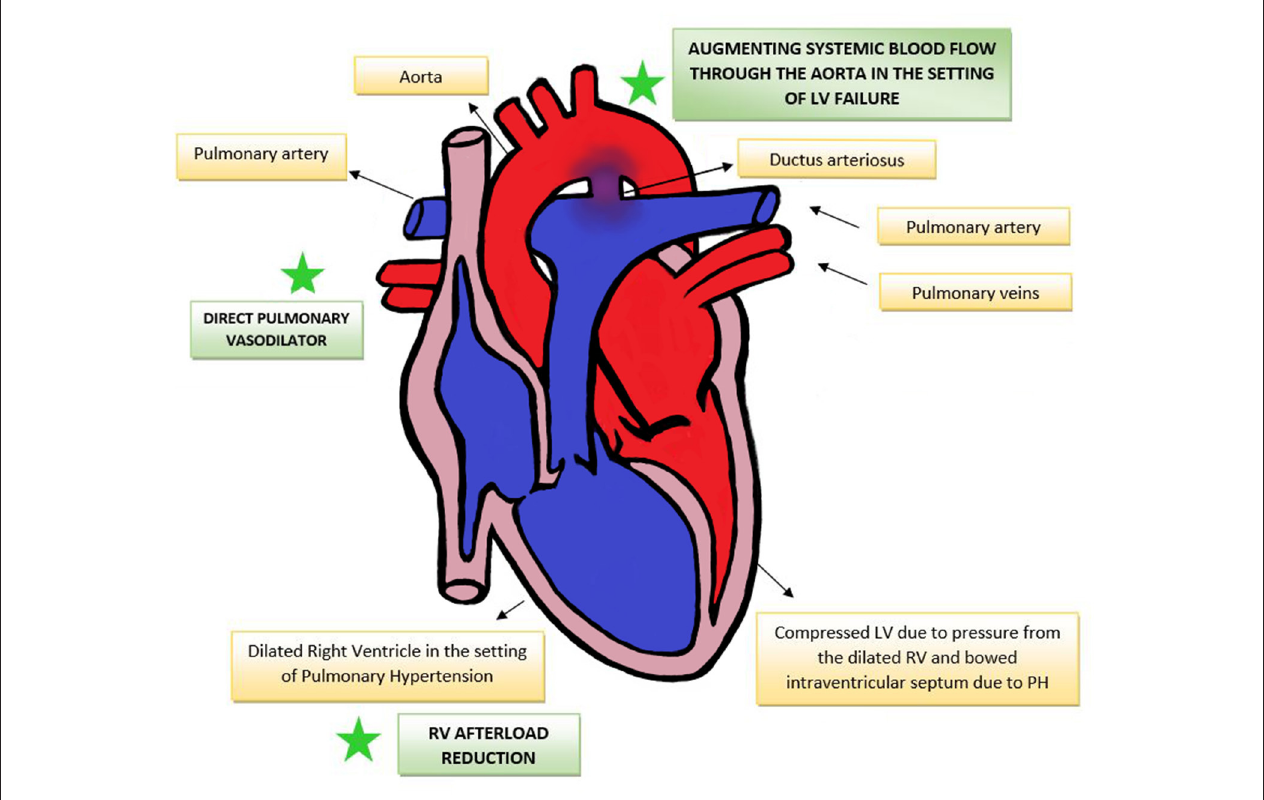
FIGURE 1 | Effect of PGE1 in PH-RV afterload reduction, direct pulmonary vasodilation and augmenting systemic blood flow. RV, right ventricle; LV, left ventricle; PH, pulmonary hypertension.